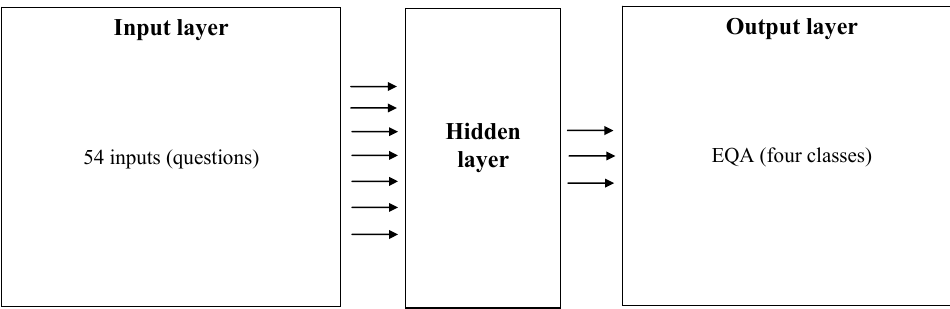
Figure 4. Artificial neural network (ANN) structure: inputs and outputs.